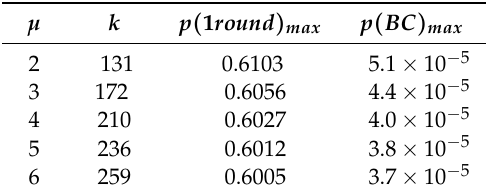
Table 3. The maximum probabilities of Alice breaking the binding of QBC protocol by replacing one state of | Ψ 0 (cid:105) ⊥ with different µ when N =